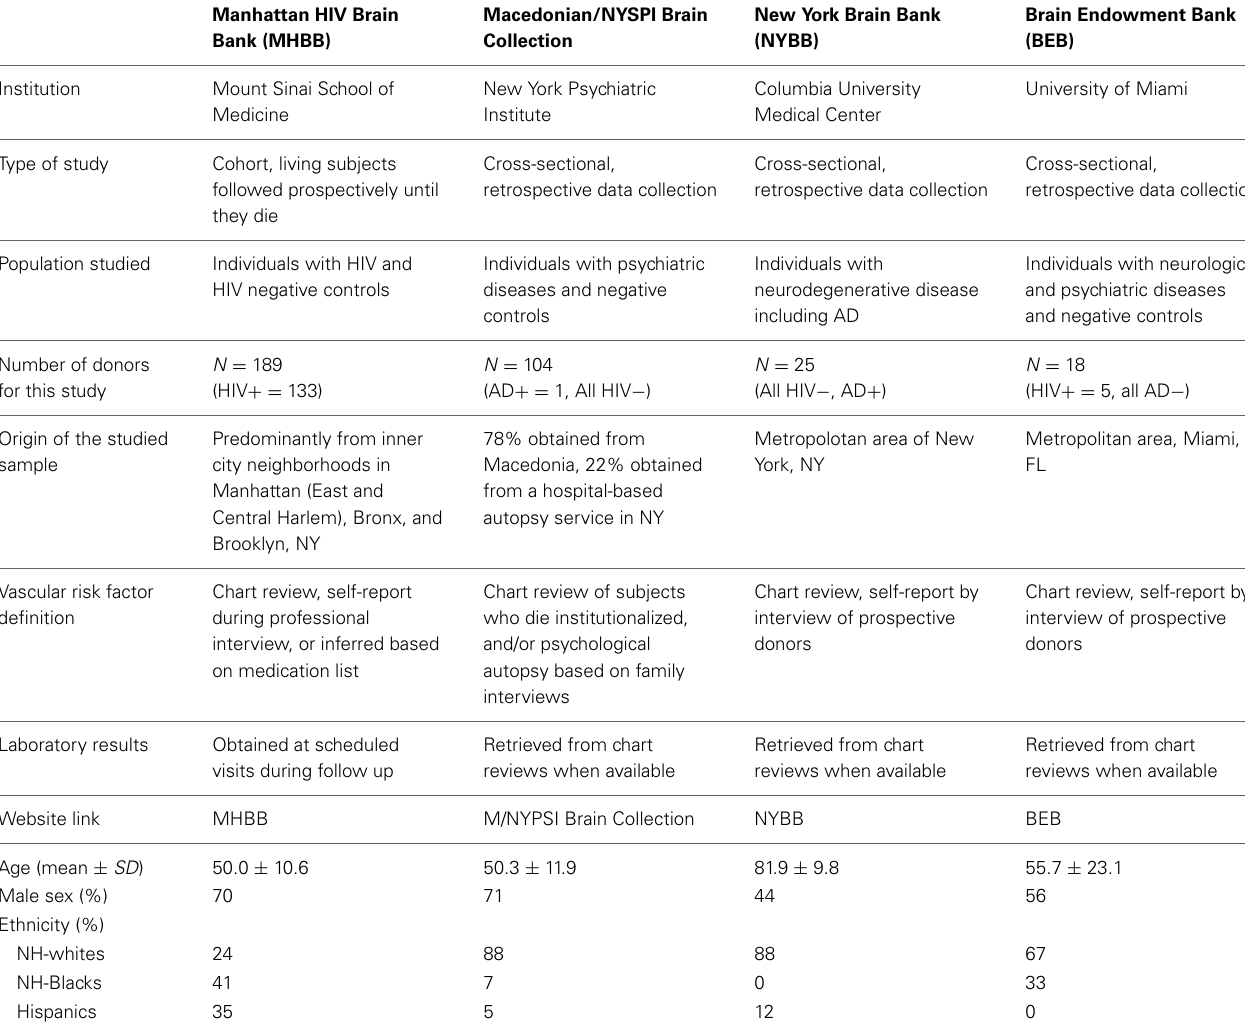
Table 1 | Characteristics of the tissue repositories from which the brain arteries were